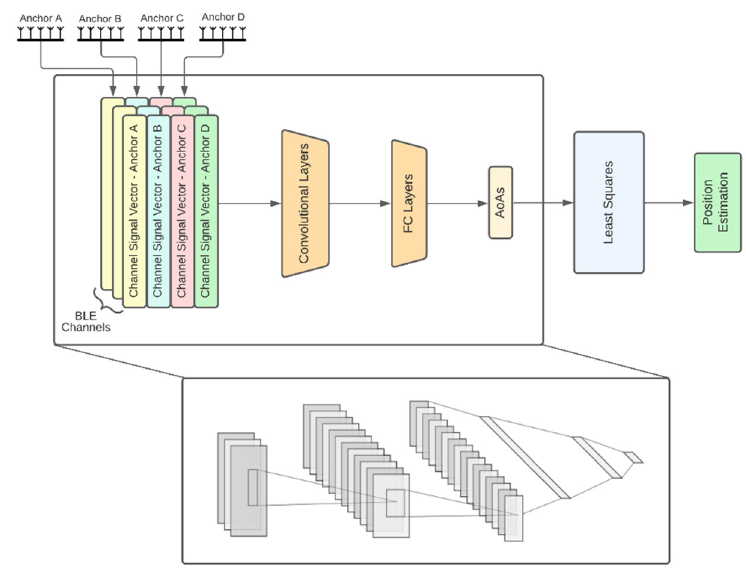
Figure 4. Architecture of CNN-based joint